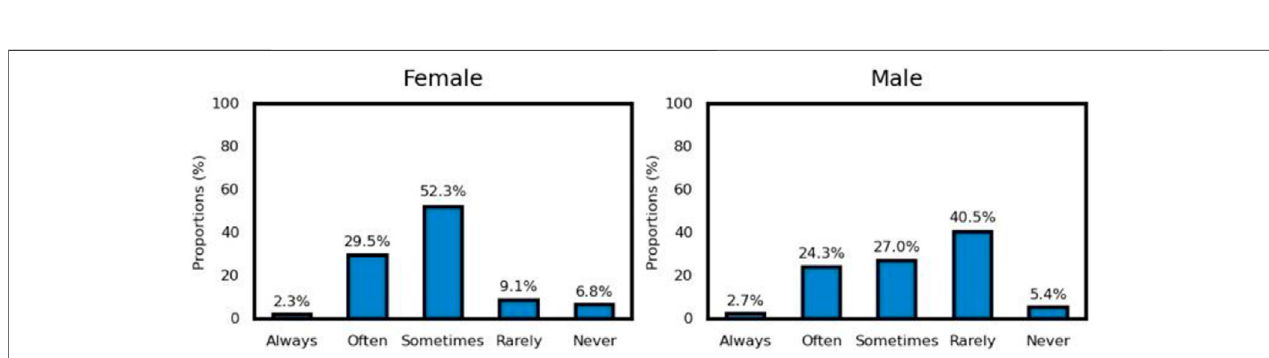
FIGURE 9 | Users ’ response to the frequency of environmental discussions in gatherings based on their gender.